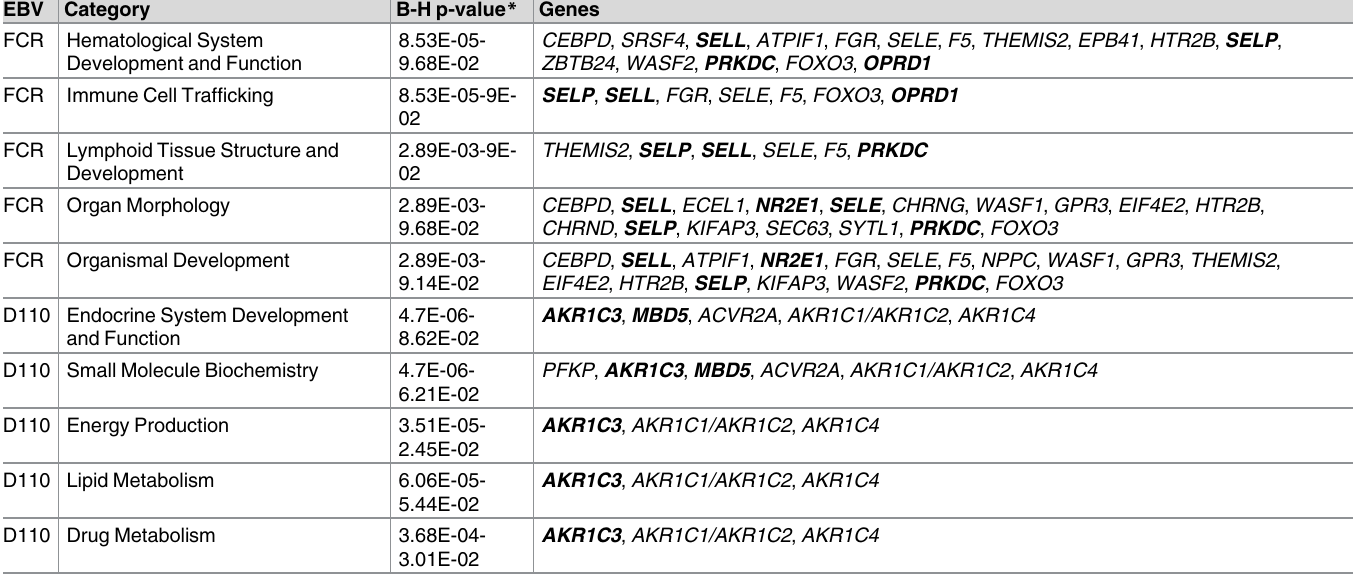
at 78.3 to 80.5 Mb on SSC 6 coincided with a QTL for FCR in a European Wild Boar x Meishan cross mapped in the region of 127.3 cM (64.9 to 89 Mb, PigQTLdb) [18]. Additionally this QTL overlapped with a QTL for body weight detected at 78.3 to 78.7 Mb in Iberian x Landrace and Iberian x Meishan crosses [19]. This QTL has thus been independently discovered in dif- ferent populations, which supports attributing it to biologically relevant common genetic variation [20]. QTL located at 86.7 to 89.1 Mb on SSC 4 found in this study was in a close prox- imity to QTL for FCR in a European Wild Boar x Pietrain cross mapped by Cepica et al. [21] at 75 cM (89.5 to 98.2 Mb, PigQTLdb). Another QTL on SSC 4 was detected at 20 cM (7.2 to 12.6